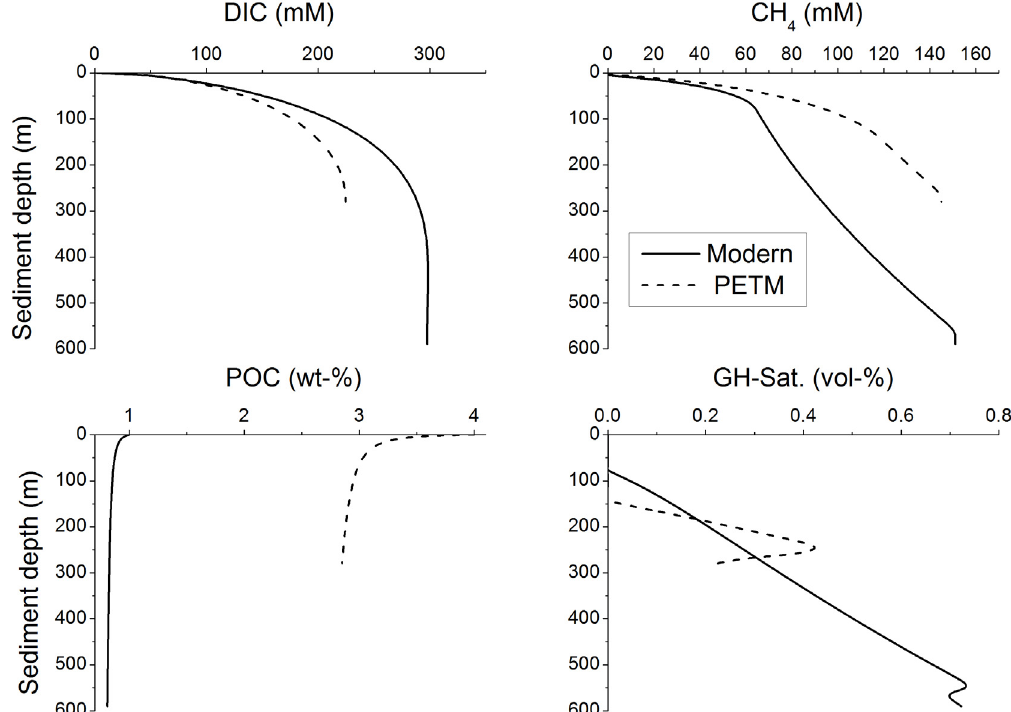
), Figure 32. Concentrations of dissolved inorganic carbon (DIC), dissolved methane (CH 4 particulate organic carbon (POC) and methane hydrate saturation (GH-Sat.) calculated for the modern ocean and the PETM. The modern ocean simulation was done for the reference = 0.0, p = 1/1300 m − 1 ). The PETM simulation case with complete compaction ( Φ f was based on the reference case with complete compaction applying a bottom water = 4 wt.% and a reduced burial velocity temperature of 10 °C, a POC concentration of POC 0 = 33.7 cm kyr − 1 of w 0